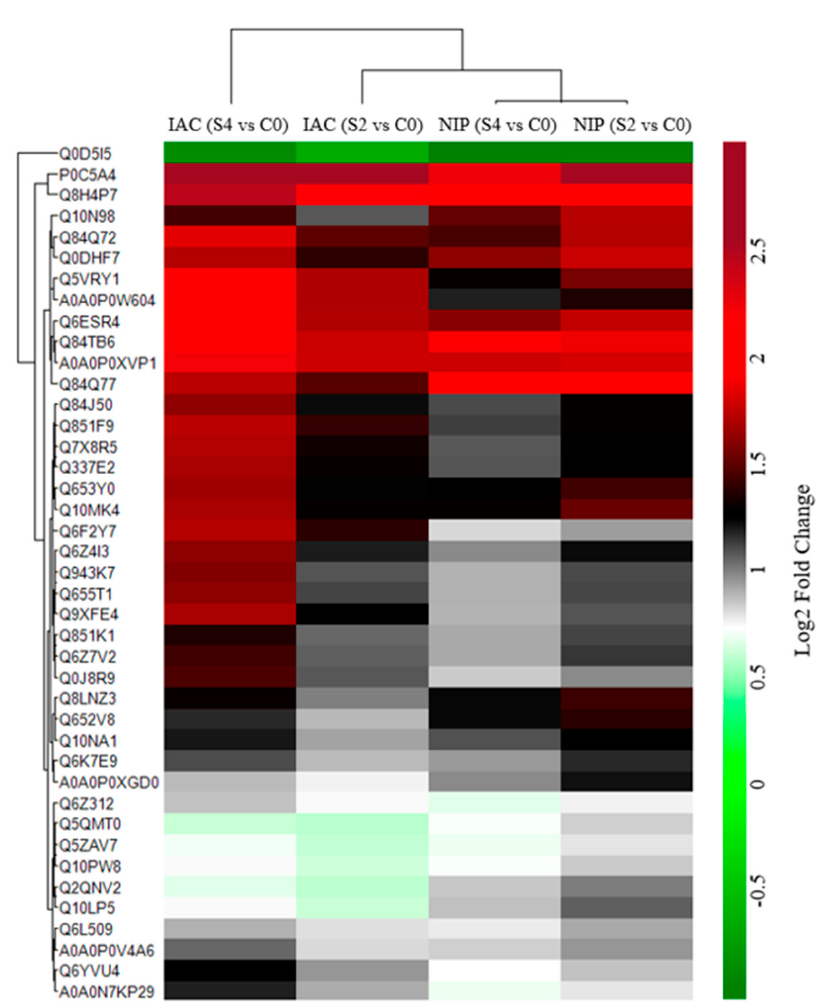
Figure 6. Expression patterns of common DEPs in IAC1131 and Nipponbare after exposure to 2d and 4d multiple abiotic stress. The fold changes of 41 significantly changed proteins were log 2- transformed. and hierarchical clustering was performed using Euclidean as the distance metric and average as the linkage criterion.